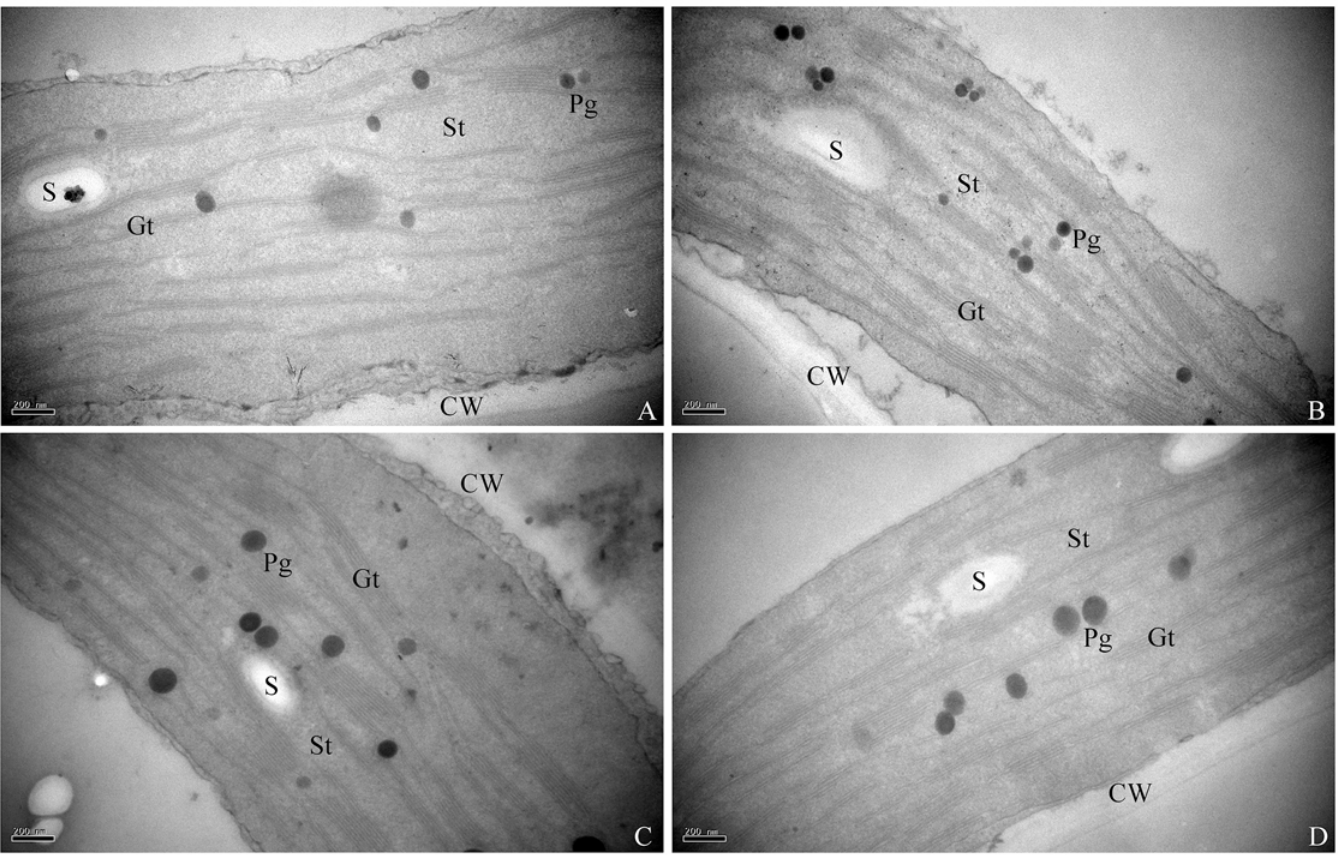
Fig 5. TEM images of the chloroplast ultra-structures at 66 day old oilseed rape seedlings. Chloroplast ultra-structures (A) control (B) nano-TiO 2 @ 500mg/l (C) nano-TiO 2 @ 2500mg/l (D) nano-TiO 2 @ 4000mg/l. CW, cell wall; St, stroma thylakoids; Gt, grana thylakoids; S, sugar grains; Pg, plastoglobuli. Bars A-B = 200